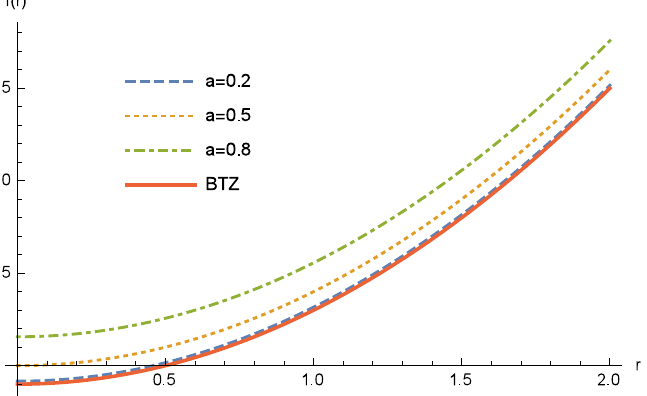
Figure 1. Modified BTZ solution. For this plot, we used M = 1 and l = 0.5 in Planckian